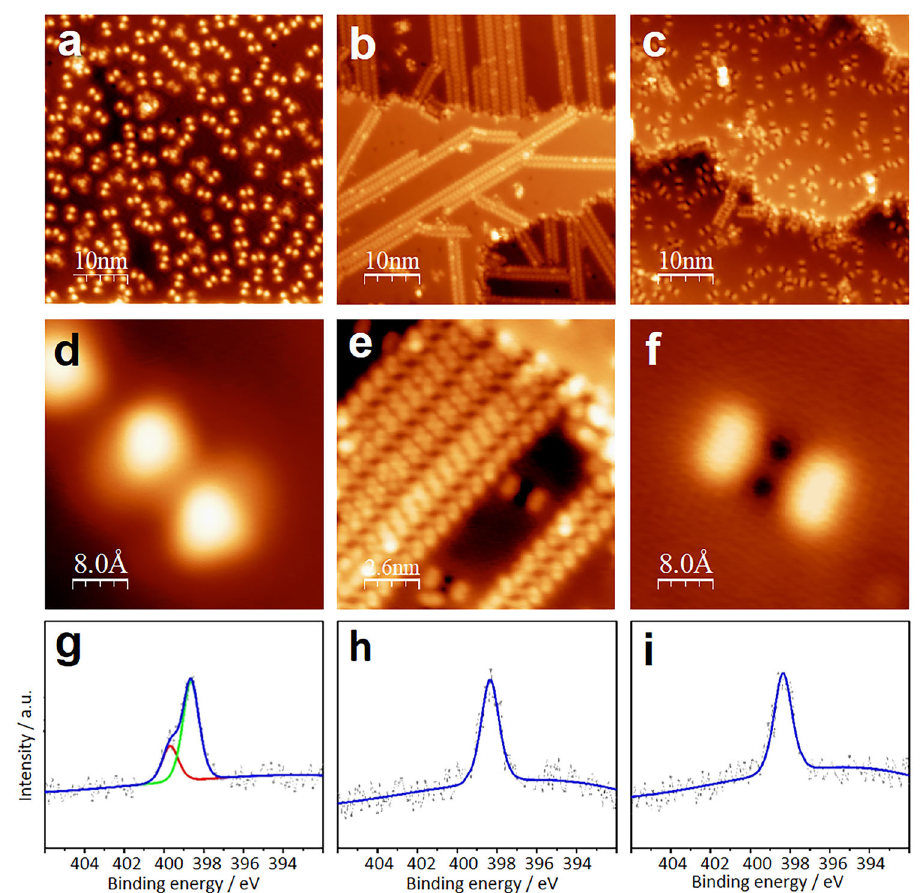
Fig. 2 Scanning tunneling micrographs showing the evolution of conformation and assembly of pyrazinacene 2 with its progressive chemical conversion/oxidation on Cu(111) of 2 on Cu(111) substrate. a Double-lobed shape of randomly distributed, individually adsorbed molecules of 2 observed after deposition onto the substrate held at room temperature (Image taken at 5 K: 50 × 50 nm, 10 pA, 1 V). b By thermal activation at ambient temperature, linear arrays form gradually within a few hours indicating a complex multi-step conversion process. This process is accelerated at elevated temperatures up to 150 °C. (Image: 50 × 50 nm, 30 pA, 500 mV). c Modi fi ed individual adsorbates observed after annealing at temperatures between 150 °C and 300 °C (Image: 50 × 50 nm, 10 pA, 1 V). The dark zone at the position of the molecular backbone and the reduced apparent height of the molecules (see also Fig. 3 and Supplementary Figs. 7 & 8) indicate their strengthened interaction with the substrate after annealing. d – f Magni fi ed images of species shown in a – c , respectively. d The double-lobe shaped monomers are chiral as marked by an ‘ S ’ (Image: 4 × 4 nm, 50 pA, 1 V). e Line structures showing packed monomers (Note that the spots are identi fi ed as phenyl rings and the lines correspond to the acene backbone — see Fig. 3) (Image: 13 × 13 nm, 30 pA, 500 mV). f The characteristic modi fi cation of the individual molecules after annealing at higher temperature: this is re fl ected in a lower peak-peak corrugation in STM (see also STM pro fi les in Supplementary Figs. 7 & 8) and in the formation of low electron Density of States (DOS) regions at their center is consistent with dehydrogenation/cyclodehydrogenation (see main text and Fig. 3c, f) (Image: 4 × 4 nm, 30 pA, 500 mV). g – i N1s XP spectra of 2 on Cu(111): g as-deposited as in a , d ; h after annealing at 150 °C as in b , c ; i after annealing at 300 °C as in c , f . For the corresponding data for 1 see Supplementary Fig.